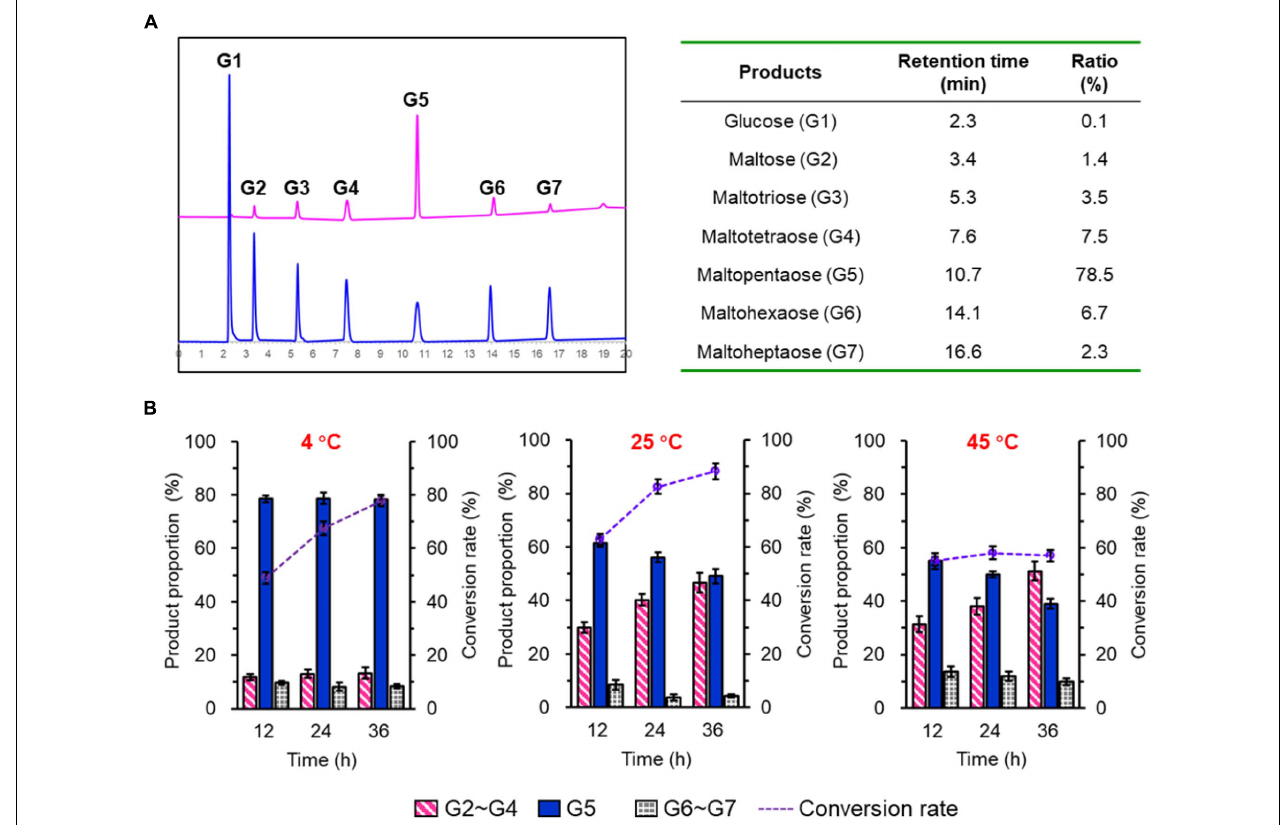
FIGURE 2 | Product profile of purified SdG5A. (A) HPAEC-PAD chromatograms of maltooligosaccharides standards (blue) and hydrolysis products of corn starch by SdG5A (pink). Product proportions calculated from the chromatogram are listed in the table. Substrates (2%, w/w) were hydrolyzed by the purified enzyme (2.0 U g - 1 dry weight of starch) at 4 ◦ C for 4 h. (B) Product composition arising from the hydrolysis of corn starch by SdG5A at different temperatures. Substrates (10%) were hydrolyzed by the purified enzyme (2.0 U g - 1 dry weight of starch). Each value represents the mean of three independent measurements (mean ± standard